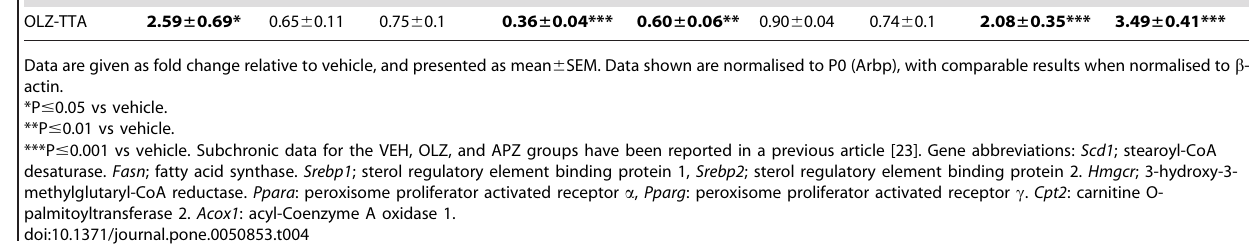
Table 4. Selected genes with drug exposure-related, differential expression in liver in the subchronic experiment.